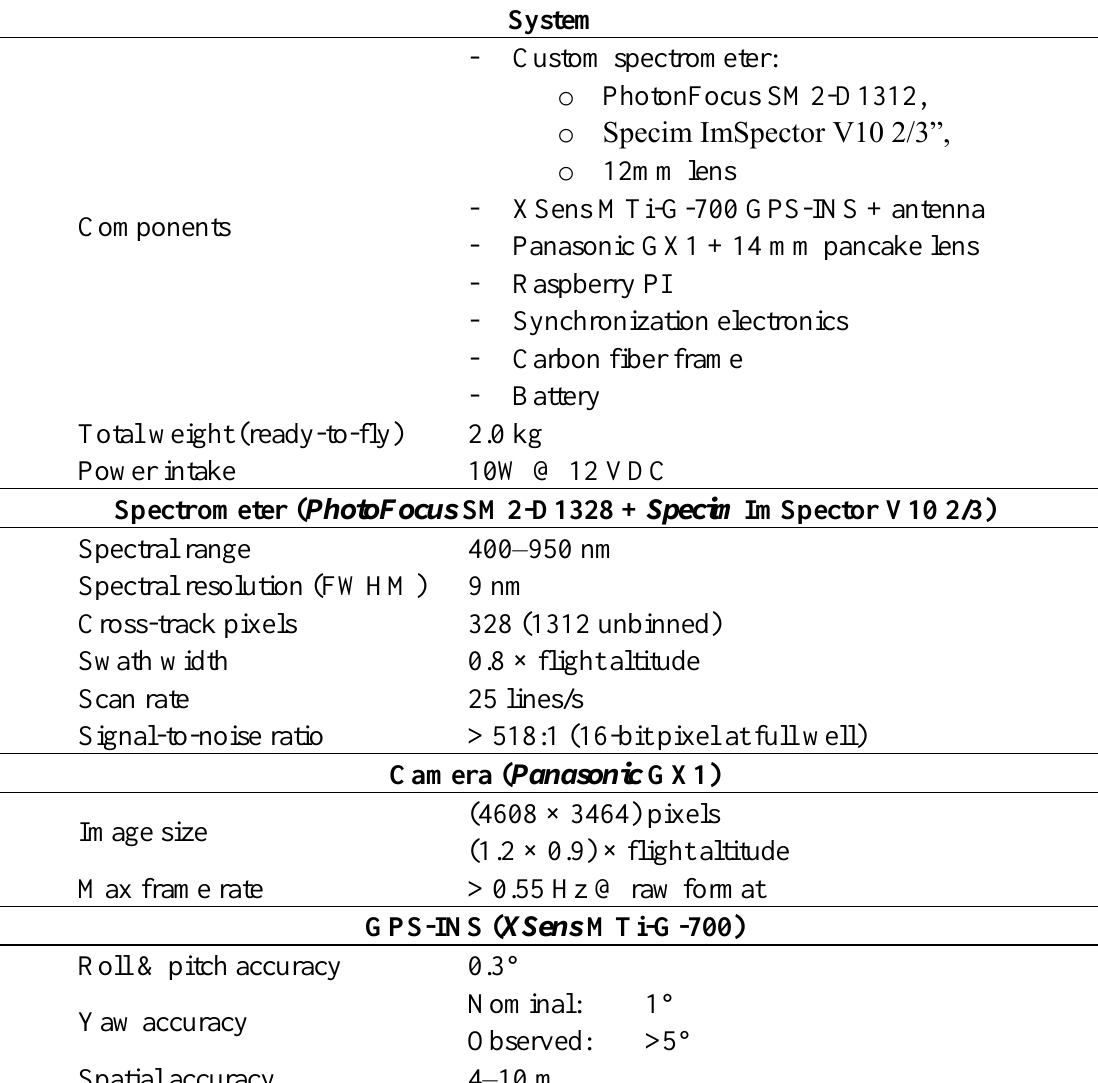
Table 1. Technical specifications of the lightweight hyperspectral mapping system